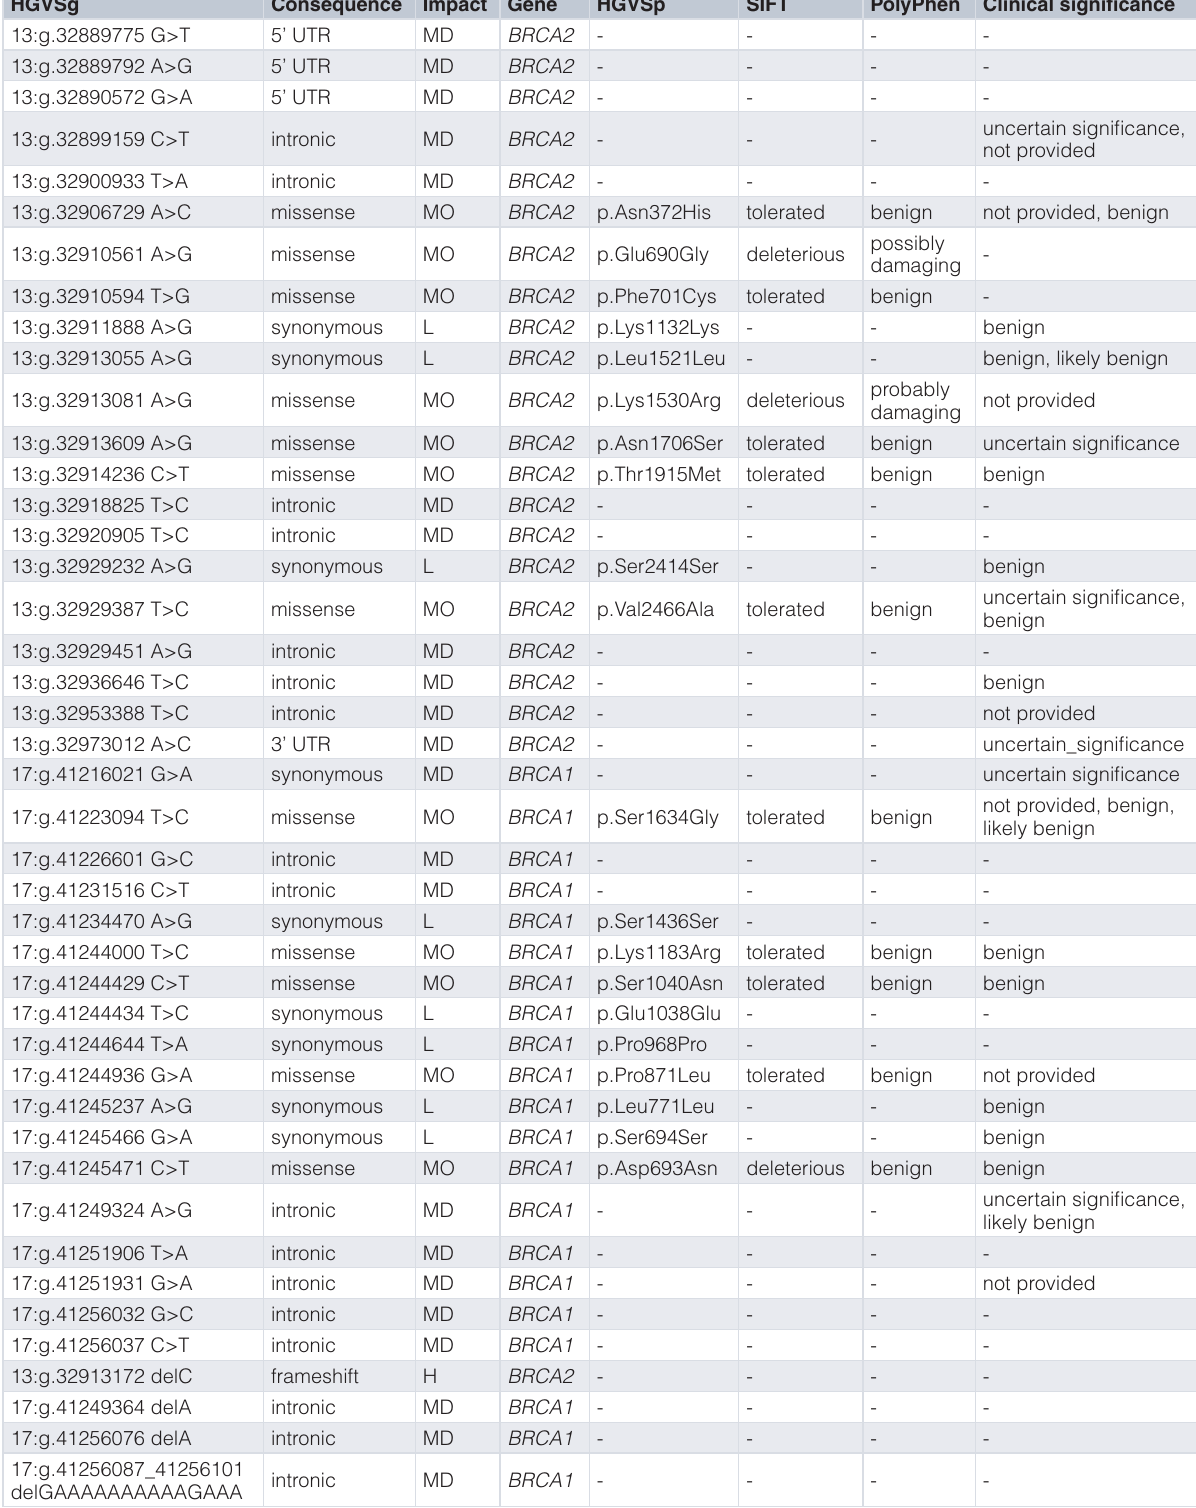
Table 3. Polymorphic variants in BRCA1 and BRCA2 genes in patients and their healthy relatives. This table provides functional annotation of mutations in BRCA1 and BRCA2 genes that passed filters during variant calling with GATK.